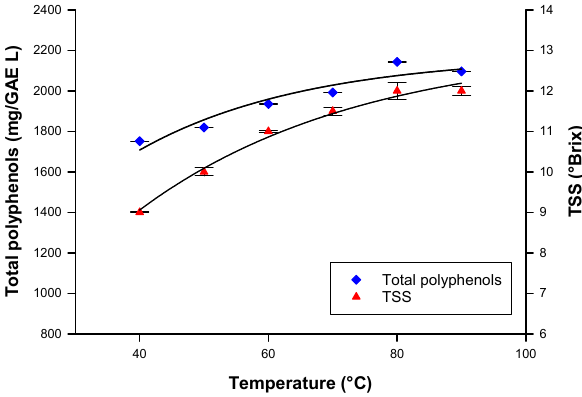
Figure 2. Effect of extraction temperature on total polyphenol and total soluble solid (TSS) yields.